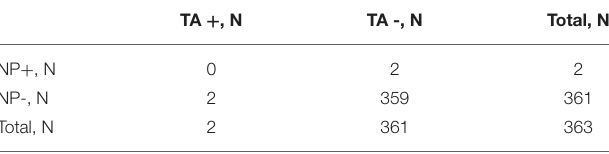
151 (41.55%) for urgent surgery. The mean age was 7.30 ± 4.89 years. No patient showed COVID-19-related